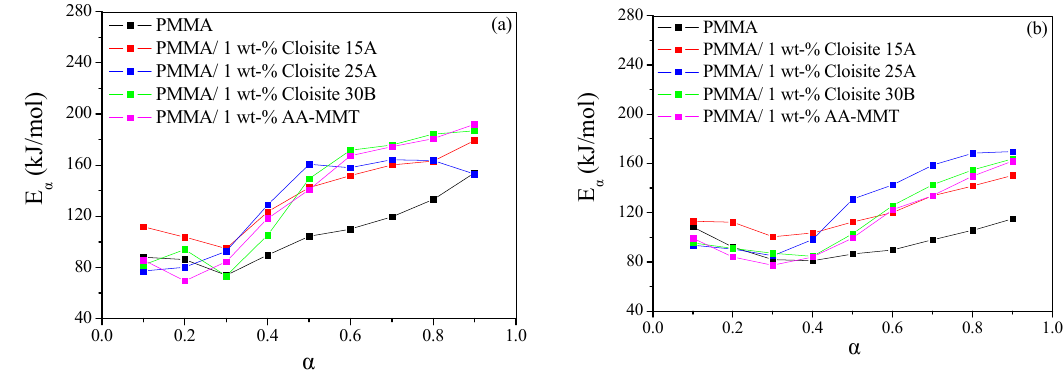
Figure 5. Effect of the OMMT type on the correlation between activation energy and extent of thermal degradation for PMMA nanocomposites determined using the method of Friedman ( a ); and the method of Coats and Redfern ( b ).